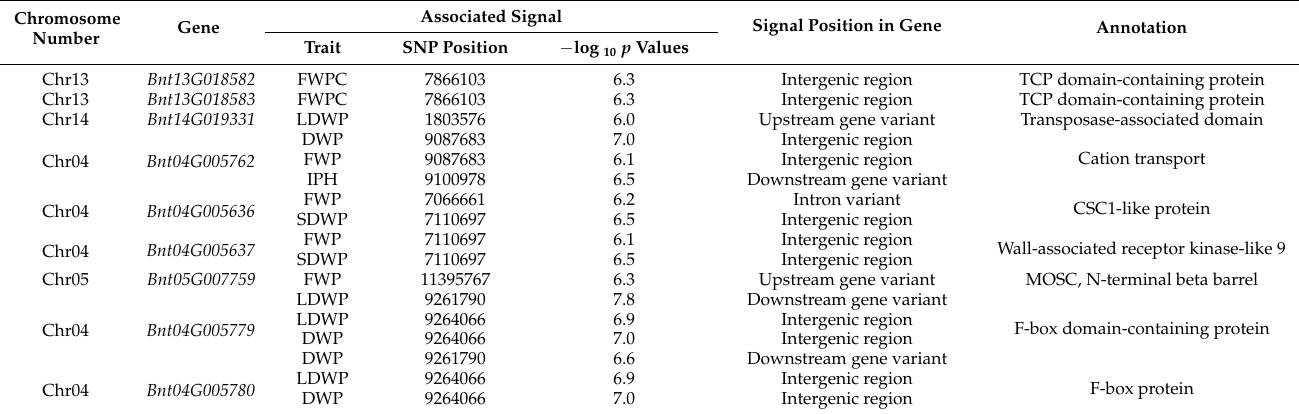
Table 5. Association signal-located genes with gene annotation in forage traits.